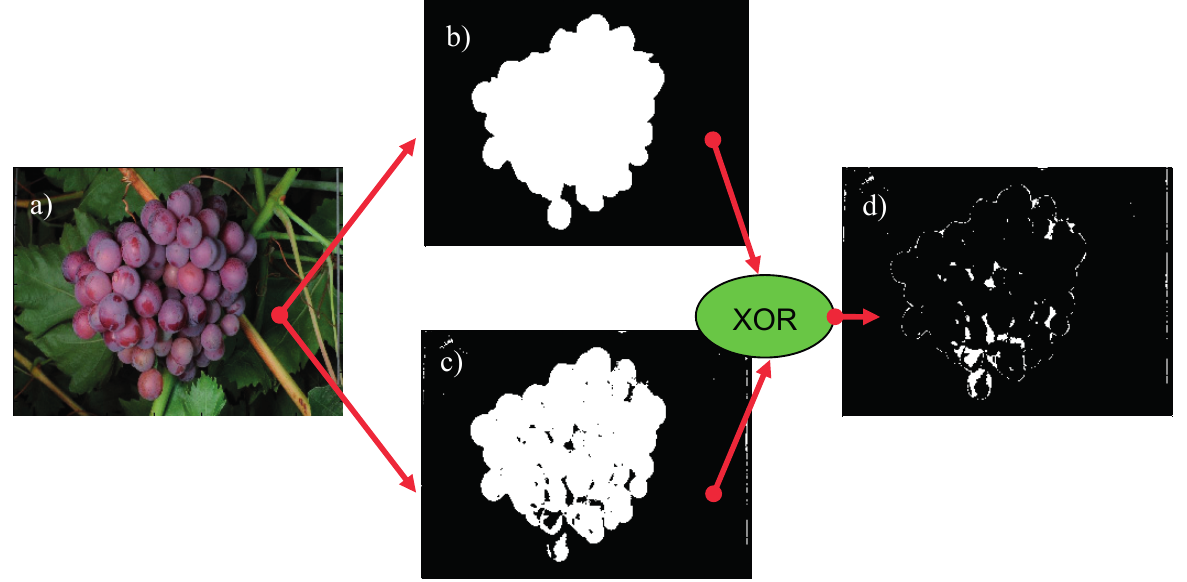
Figure 6. ( a ) Vineyard image with a cluster of grapes; ( b ) Manual labeling of the cluster of grapes; ( c ) Example automatic grape segmentation results; ( d ) XOR differences between the manual labeling and the automatic